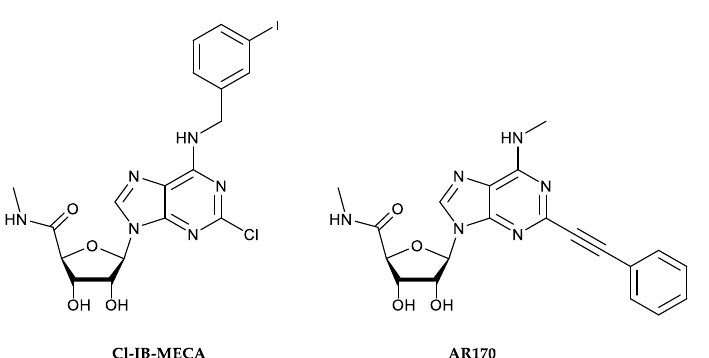
Figure 1. Chemical structures of the A 3 AR reference agonist 2-chloro- N 6 -(3-iodobenzyl)-adenosine-5′- N -methyluronamide (Cl-IB-MECA, left ) and the potent and selective A 3 AR agonist AR170 ( right ) employed in this study.